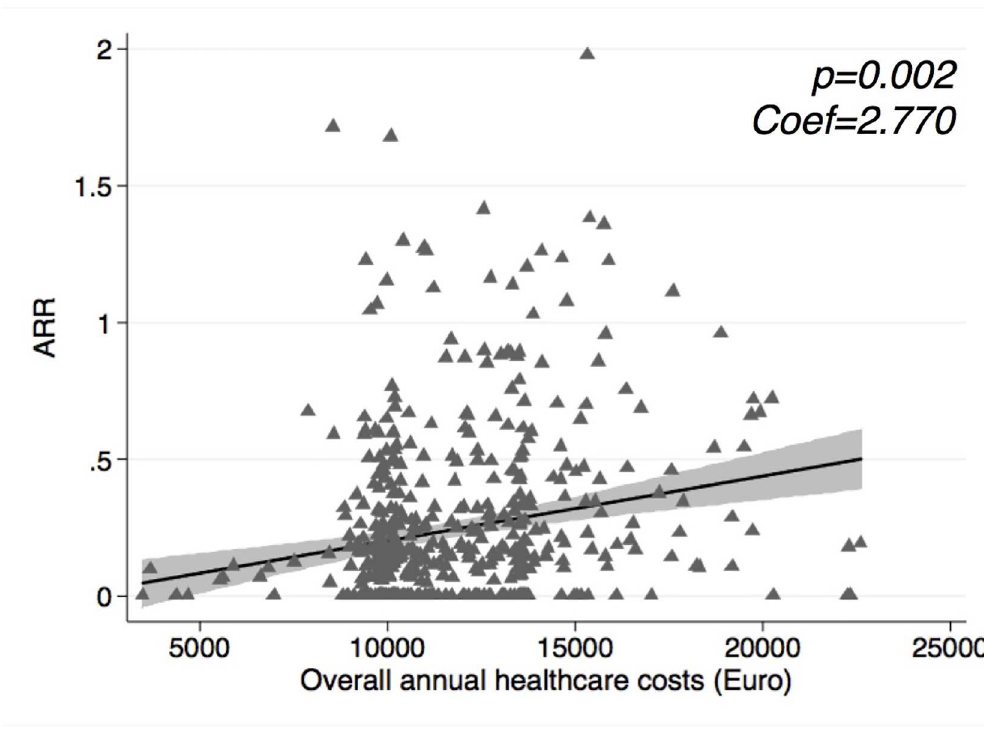
Fig 3. Scatterplot for overall annual healthcare costsand relapses. Scatter plot showingthe relationship betweenoverallannualhealthcarecosts and the ARR. P-valueand coefficientfrom Poisson regressionanalysisare shown;95% confidenceintervalsare represented in greyshadow.ARR: Annualised RelapseRate; Coef: Coefficient.